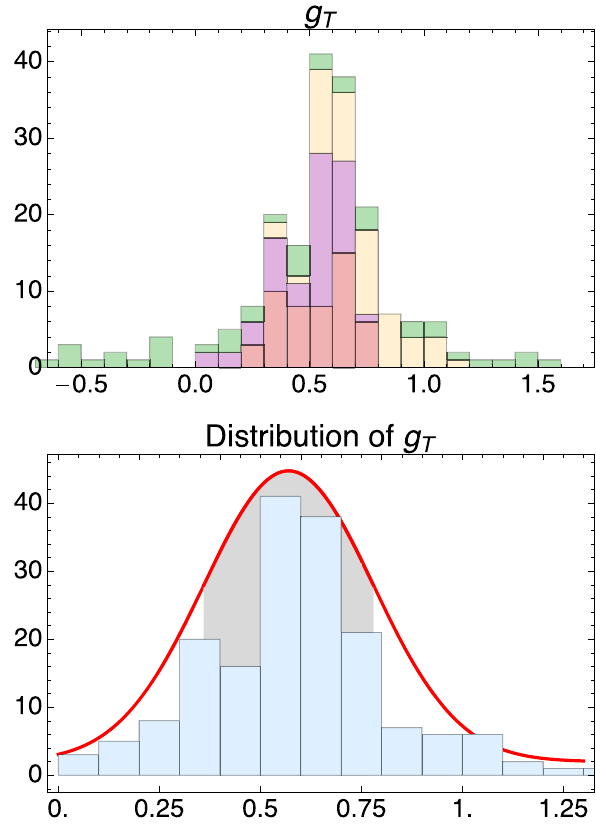
Fig. 8 Upper plot: Comparison with the isovector combination of the transversity PDF of this work, in cyan meshed crosses, with the result at 4 GeV 2 obtained through the global fit of Ref. [9], in meshed pink, both at 90 % CL. These collinear extractions are compared to lattice QCD evaluations from the ETM Collaboration [38], in gray, and the LP 3 Collaboration [39], in dashed blue. Lattice results correspond to a scale of 4 GeV 2 . Lower plot: same as upper plot with logarithmic x -scale at 1 σ ; the 2 σ error is 0 . 42. The truncated tensor charge is